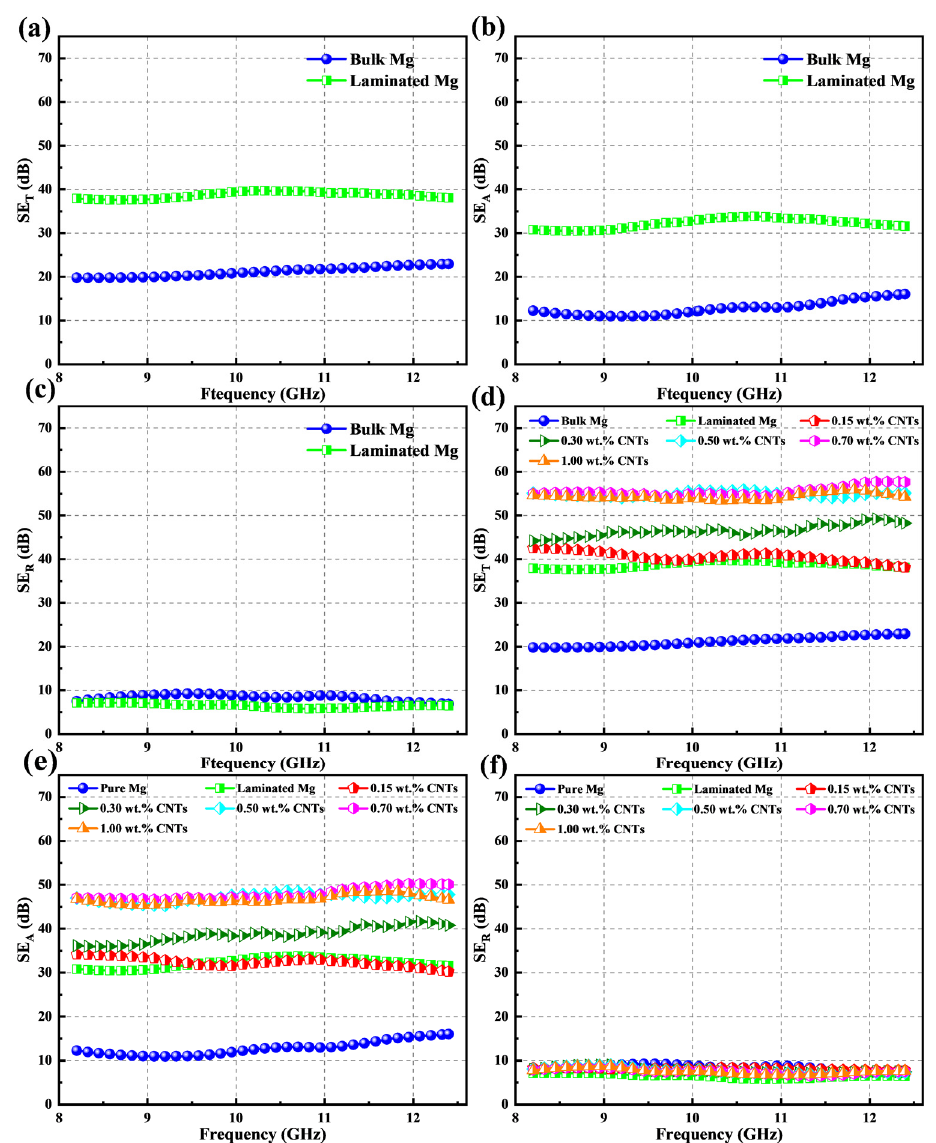
Figure 5. The EMI SE results of bulk Mg, laminated Mg and CNTs/Mg composites in the X-band. ( a – c ) total (SE T ), absorption (SE A ) and reflection (SE R ) shielding effectiveness of bulk Mg and lami- nated Mg, respectively; ( d – f ) total (SE T ), absorption (SE A ) and reflection (SE R ) shielding effectiveness of laminated CNTs/Mg composites with different CNT contents, respectively.